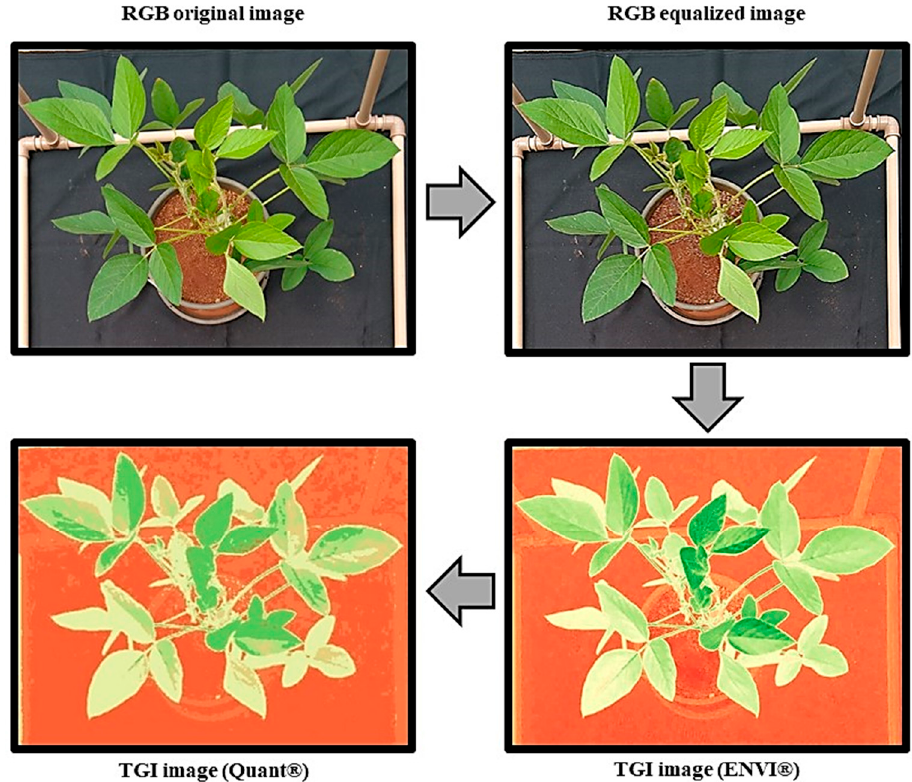
Figure 2. The sequence of image composition from the original image to estimate soybean canopy area (cm 2 ) of the predominant green shade (dark-green), expressed by the vegetation triangular greenness index (TGI). It can be observed that image treatment removes the background colors that are not plant-related. RGB: Red, green, blue.